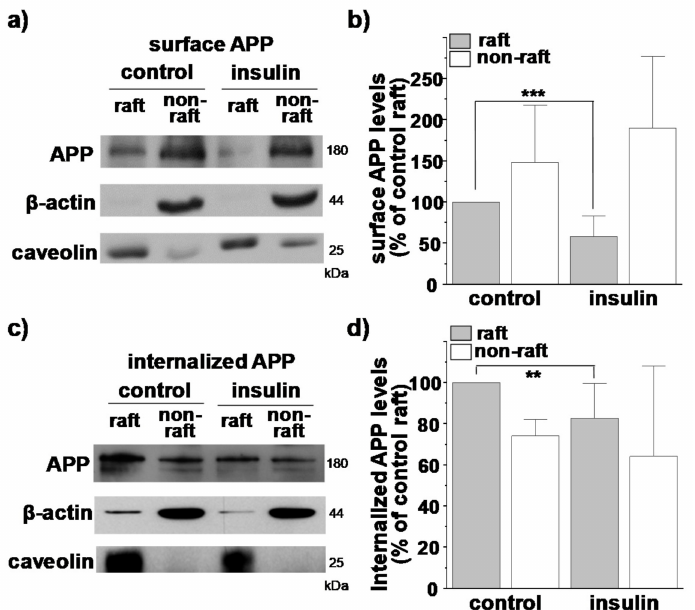
Figure 4. O-GlcNAcylation decreases APP internalization from lipid rafts. SH-SY5Y-APP/BACE cells were incubated with insulin for 2 h. ( a ) To examine APP localization at the plasma membrane, cells were incubated with EZ-Link NHS-biotin for 10 min at 4 ◦ C to label all surface proteins. Biotin-labeled cell lysates were then loaded onto discontinuous sucrose density gradient to separate lipid raft and non-lipid raft fractions as described in the Methods section. A typical result shows surface APP levels in lipid raft and non-raft fractions. ( b ) Quantitative analysis of surface APP was shown ( n = 7, number of independent experiments). Surface APP levels were compared to the levels of surface APP in raft fractions of control cells. ( c ) To examine whether APP endocytosis occurred in lipid rafts, cells were incubated with EZ-Link NHS-SS-biotin for 10 min at 4 ◦ C to label surface proteins. Cells were then incubated at 37 ◦ C for 5 min to allow internalization of biotin-labeled surface proteins. After internalization, remaining surface-bound biotin was removed, and biotin-labeled cell lysates were loaded onto a discontinuous sucrose density gradient to separate lipid raft and non-lipid raft fractions as described in the Methods section. Internalized biotin-bound APP levels in lipid raft and non-raft fractions were determined with Western blots. ( d ) Analysis of band densitometry showing levels of internalized APP ( n = 7, number of independent experiments). Levels of internalized APP were compared to the APP levels internalized from lipid rafts in control condition. Caveolin was used as a lipid raft marker. One-way ANOVA: **, p < 0.01; ***, p < 0.001. All values represent the mean ±